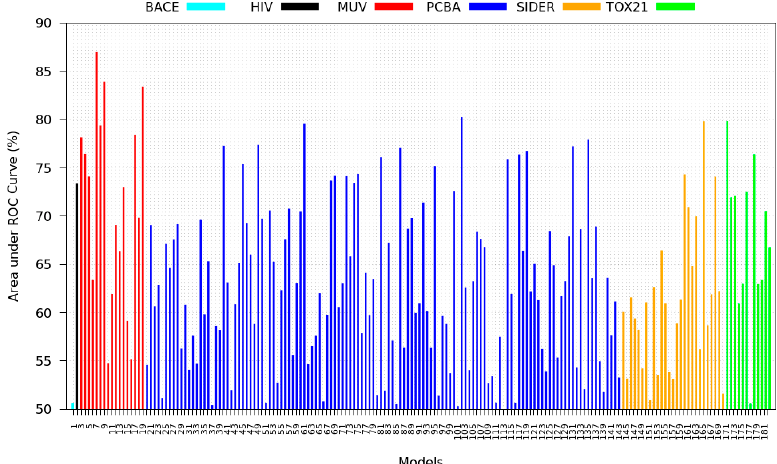
Figure A6. Detailed performance of pre-trained models inferring on target validation set without fine-tuning. (Correlation to improvement: 0.22)